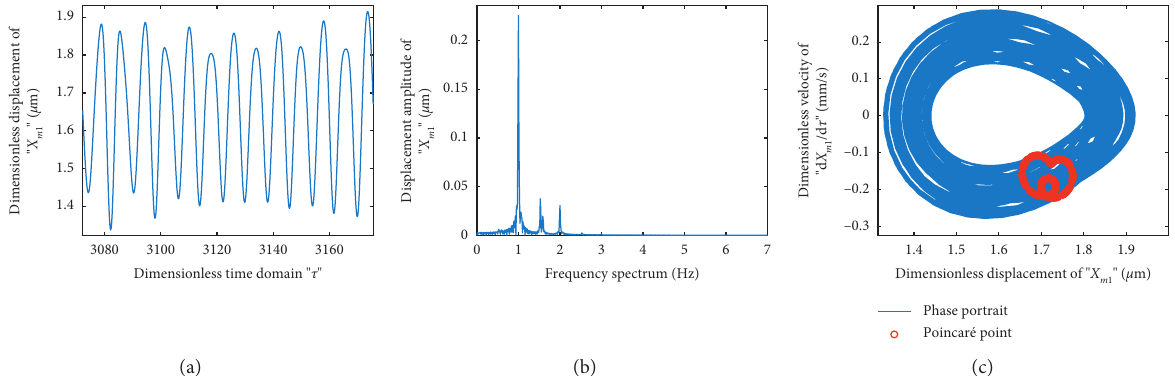
Figure 5: The dynamic response of system X m 1 at 16950rpm. (a) Time-domain response. (b) FFTspectrum. (c) Phase plane and Poincar´e point.